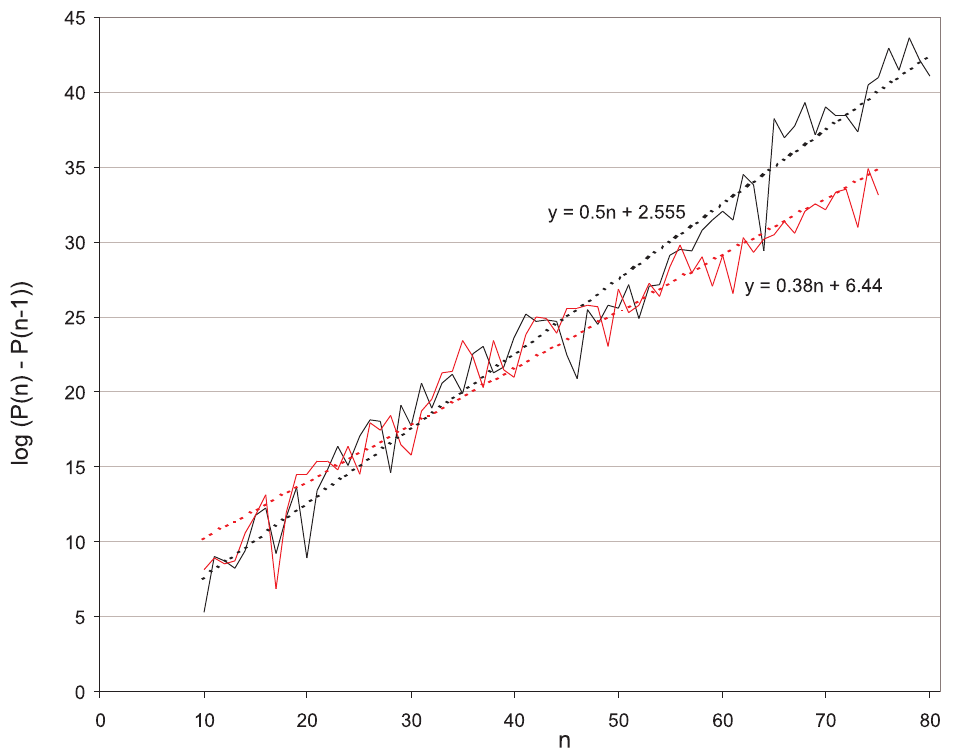
Figure 10. Inter-record times P ( n ) − P ( n − 1 ) for gaps between primes (black) and a similar quantity P c ( n ) − P c ( n − 1 ) for gaps between twin primes (red). Lines are exponential fits. Values for n < 10 are